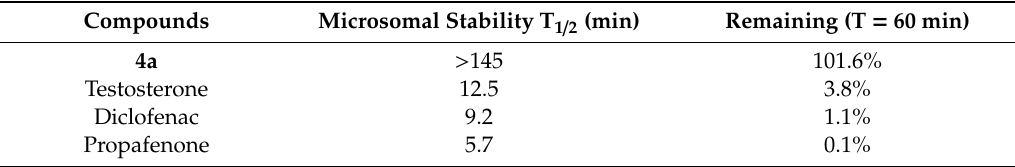
Table 3. Human liver microsomal stability of compound 4a